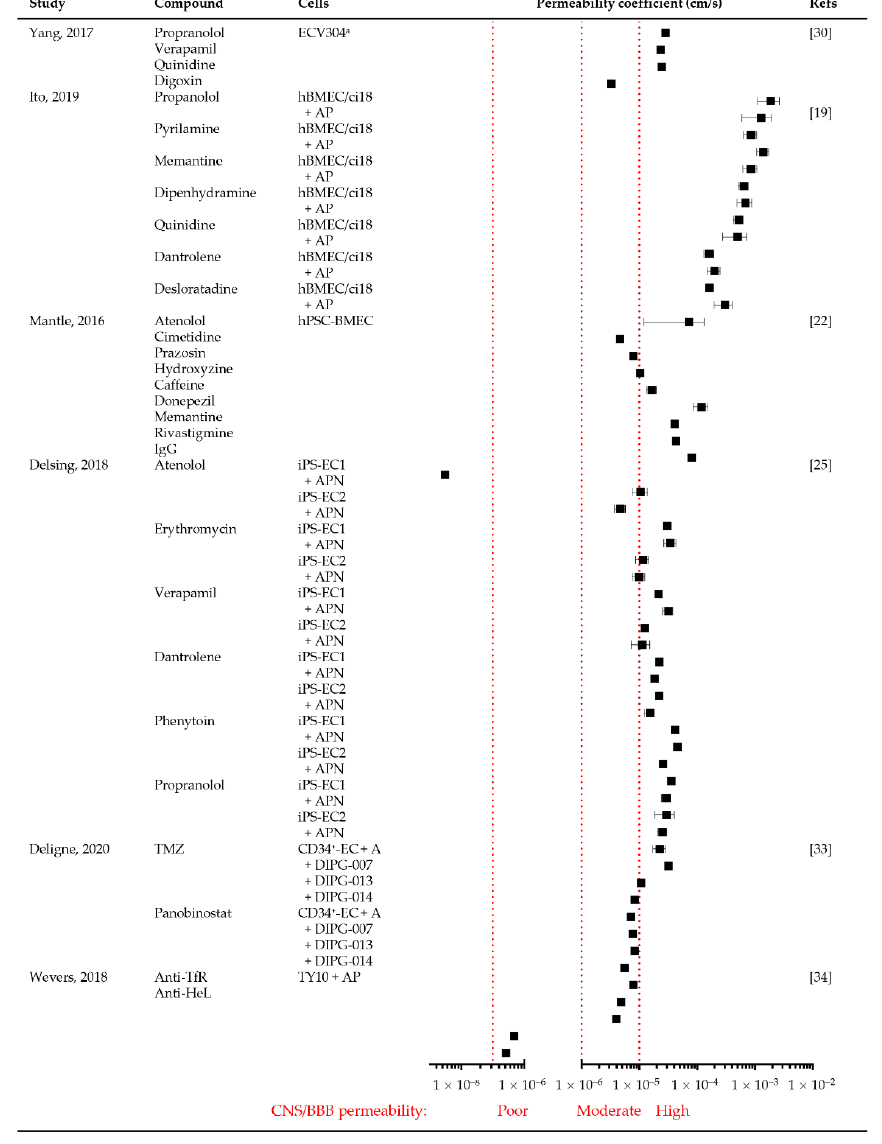
Figure 6. In vitro permeability coefficient values for drugs. Forest plot shows permeability coefficients determined in in vitro BBB models using stem (iPSC), primary and immortalized ECs with or without astrocyte (A), pericytes (P) and neurons (N). Compound molecular weights are presented in Table S4. Symbols show mean ( ■ ) ± SD for the reported experiments. a ECV304 was later identified to be a human urinary bladder carcinoma cell line, presenting many EC phenotypic characteristics [30] . High, moderate and poor CNS/BBB permeability is denoted by red dotted lines at >10 −5 , 10 −6 and 10 −7 cm/s, respectively.